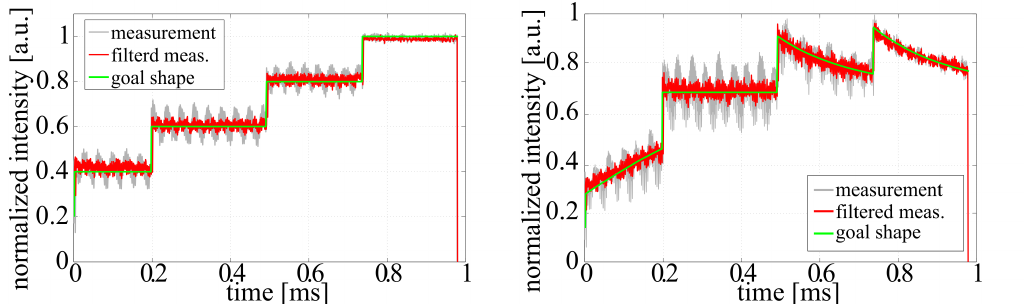
( Left ) Stair-shaped input pulse train; ( right ) resulting output pulse train after amplification.